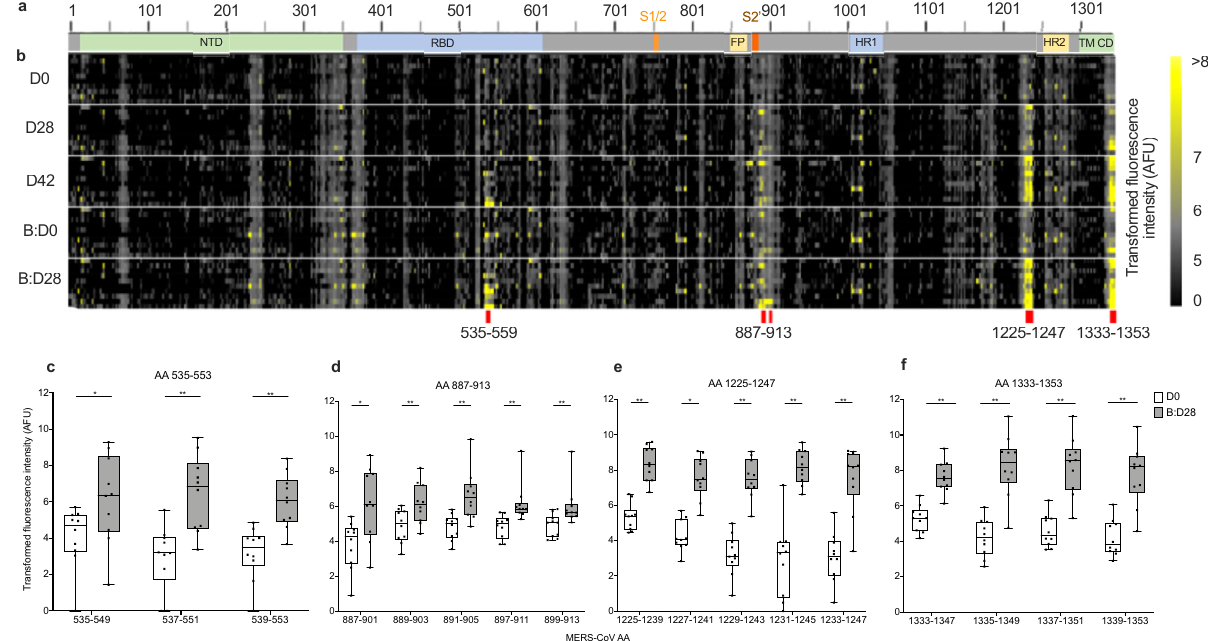
Fig. 5 Identi fi cation of four immunogenic MERS-CoV-S epitopes. a Schematic representation of the MERS-CoV-S protein. The N-terminal domain (NTD), receptor-binding domain (RBD), S1/S2 cleavage site (S1/S2), fusion peptide (FP), S2 ‘ cleavage site (S2 ‘ ), heptad repeat 1 and 2 (HR1, HR2), transmembrane domain (TM) and cytoplasmic domain (CD) are illustrated. b Microarray of 15-mer peptides spanning the complete MERS-CoV-S protein with a 13 amino acid (AA) overlap. Immunogenic B-cell peptides are marked with red lines. c – f IgG binding to the respective peptides on MERS-CoV-S was measured in fl uorescence intensity (as arbitrary fl uorescence units, AFU), depicted as transformed values (areas sinus hyperbolicus (asinh), y axis), in all booster study participants ( n = 10). Mean levels of peptide-binding IgG at baseline (Day (D) 0 (D0), white boxes) and 28 days after booster vaccination (Boost